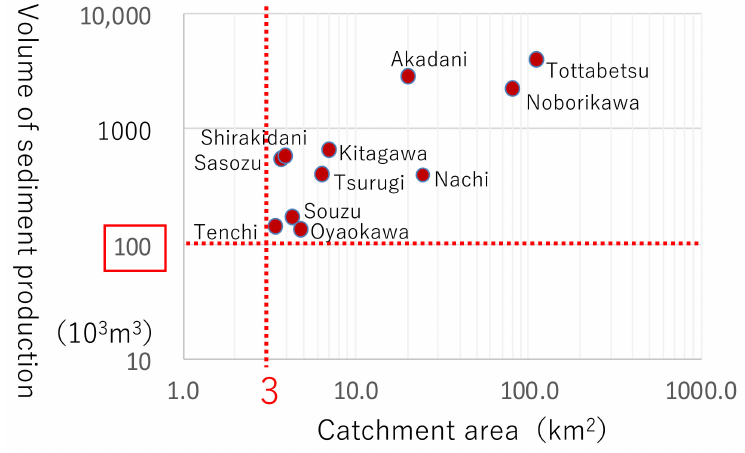
Figure 5. Relationships between catchment area and volume of sediment production of rivers that have experienced sediment-laden floods from 2009 to 2018 (cited from Sakai et al., 2021 [69]).